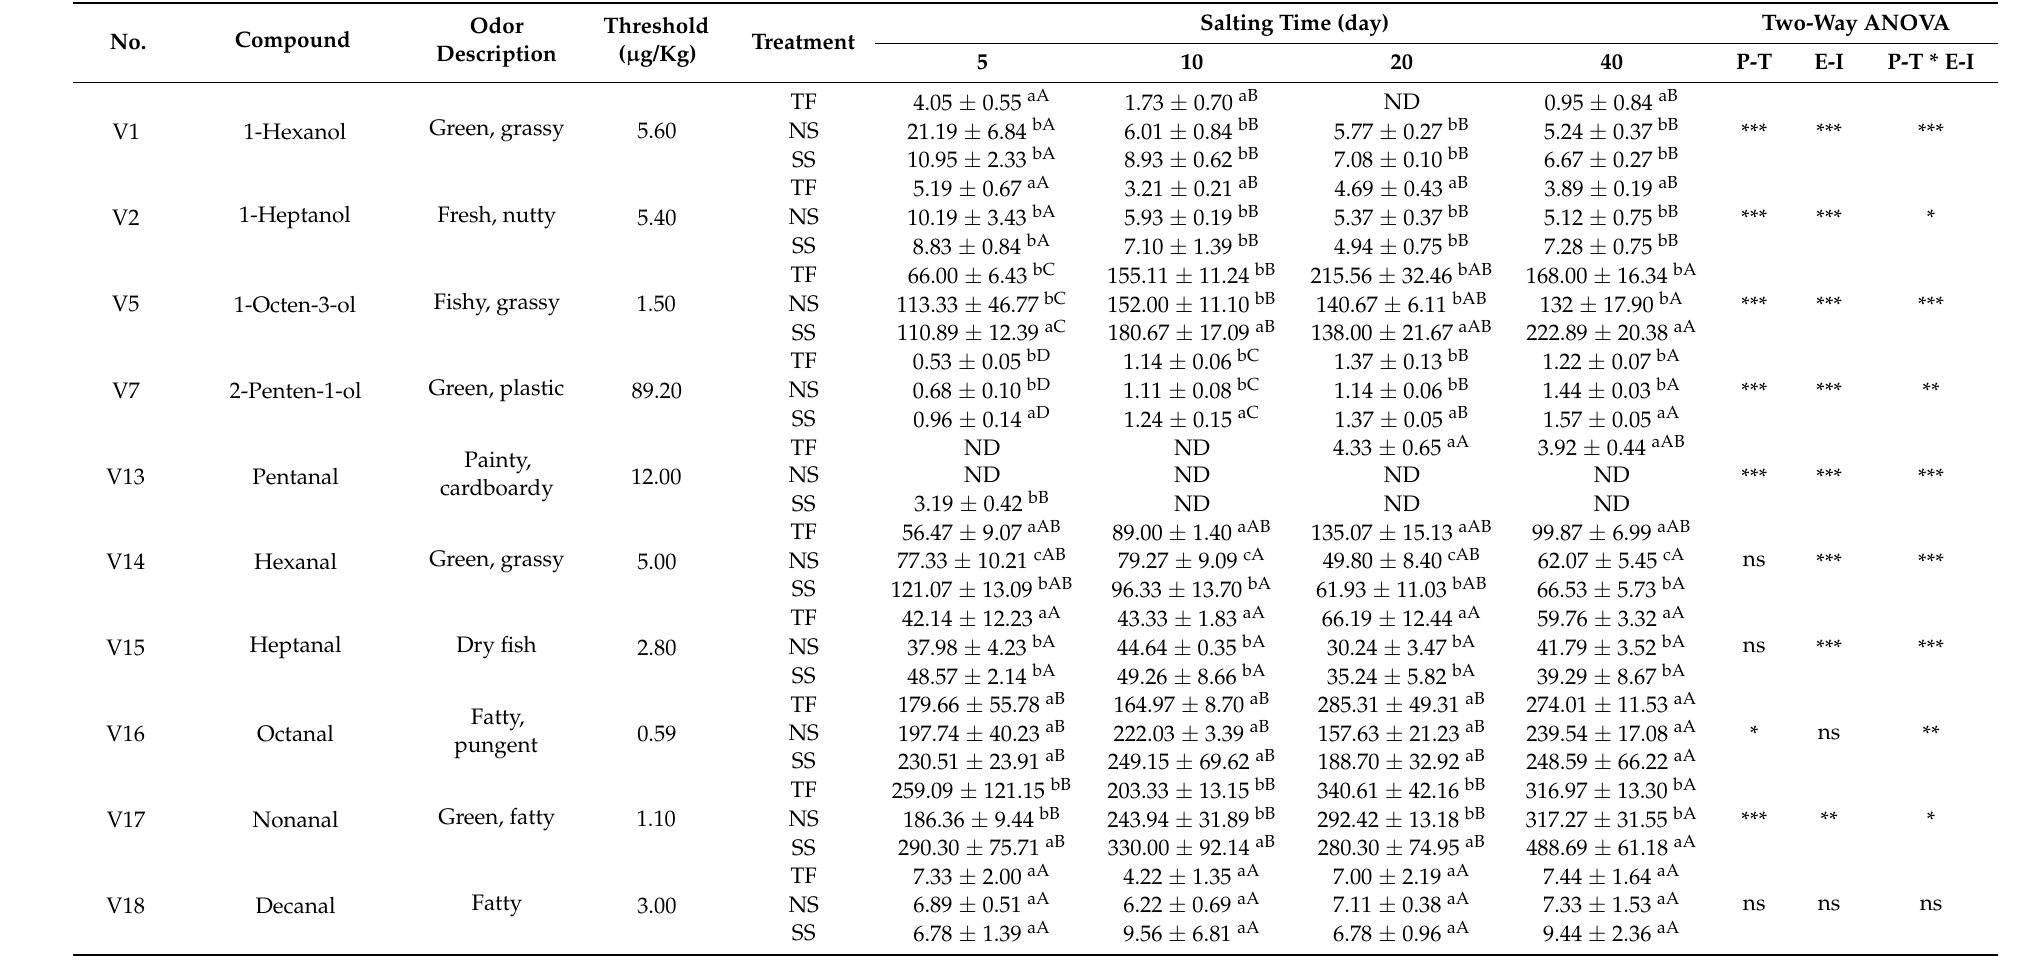
Table 2. The OAV, odor descriptions, and threshold values of volatile components in the salted herring